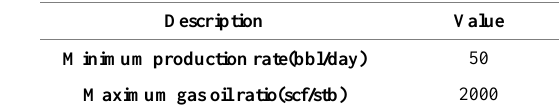
Table 8. Abandonment condition